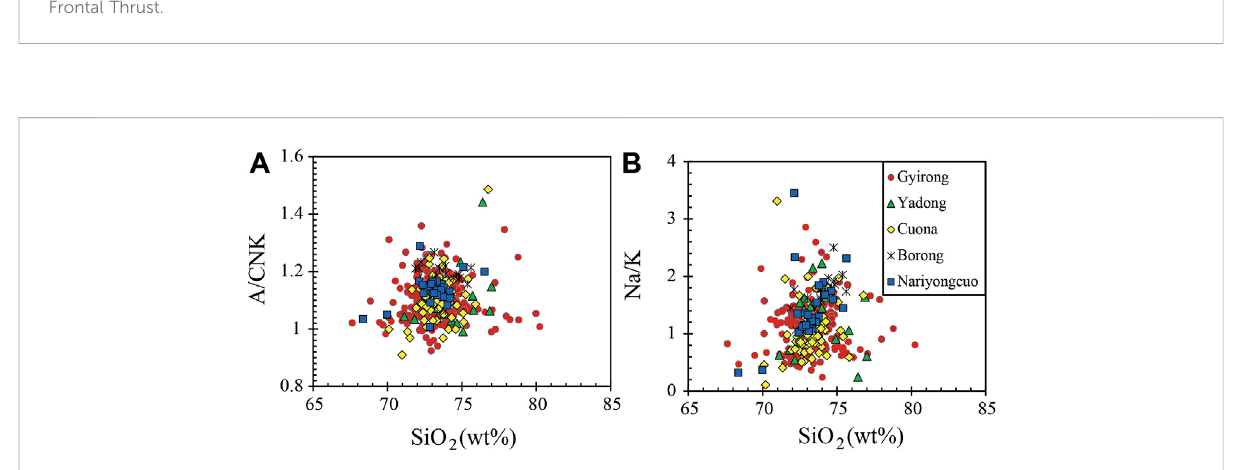
FIGURE 2 Major elemental characteristics of the Himalayan Miocene